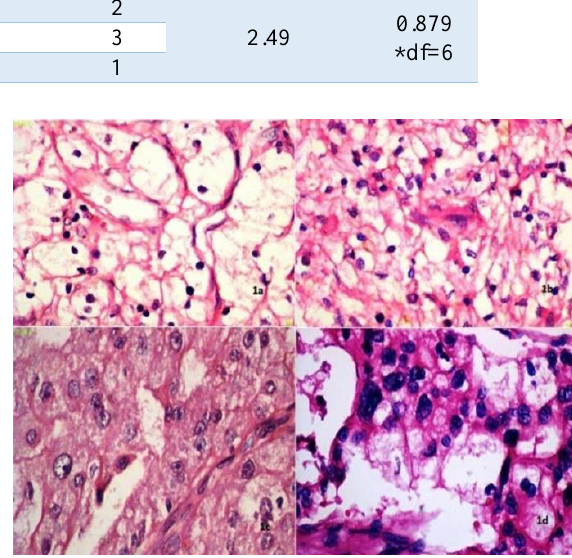
Fig 1. Fuhrman nuclear grading in clear cell